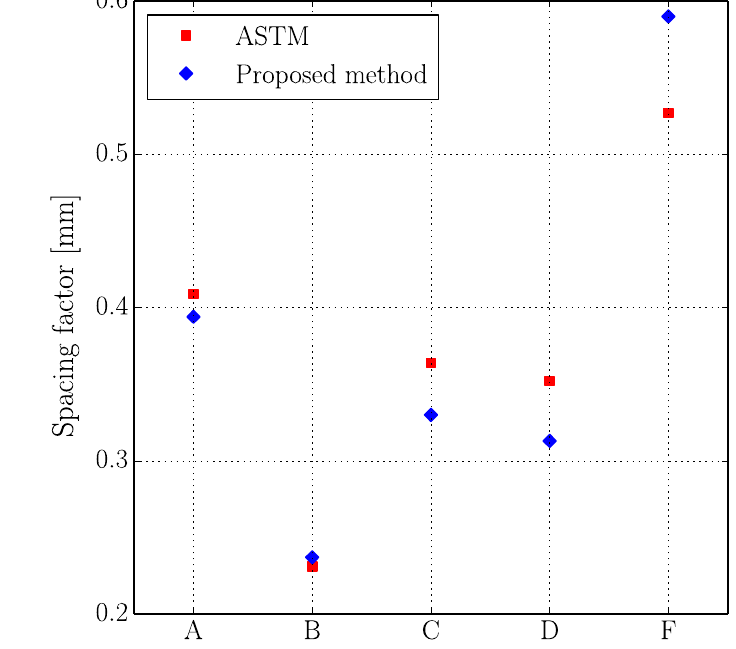
Figure 12. Results of the spacing factor of the slabs studied using the original and the proposed